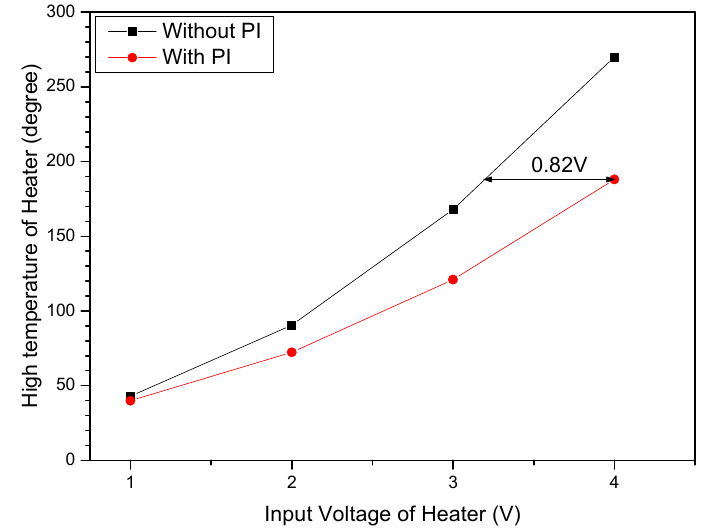
Figure 12. Comparison between heat generation characteristics of input voltage depending on the presence of a PI coating.